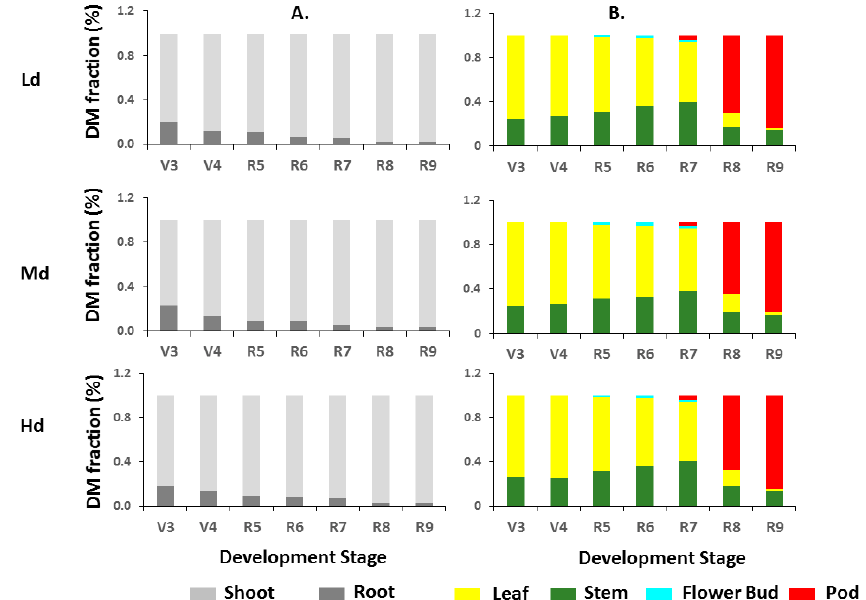
Figure 6. Average fractions ( A ) of roots and shoots in total biomass and ( B ) distribution of shoot biomass over leaves, stems, flower buds and pods of growth habit III Flor de Mayo Bajio dry bean ( Phaseolus vulgaris L.) cultivar established at 90,000 plants ha − 1 (Low density, Ld), 145,000 plants ha − 1 (Medium density, Md) and 260,000 plants ha − 1 (High density, Hd) under rainfed conditions during the 2011 growing season in Pabellon de Arteaga, Aguascalientes, Mexico.